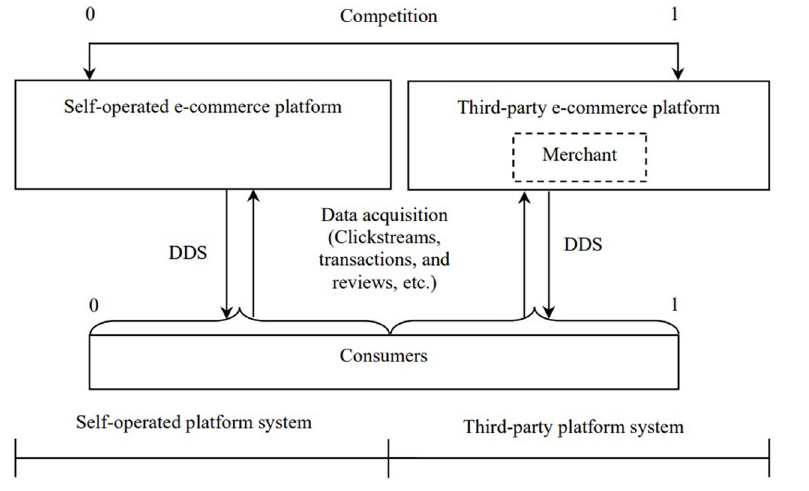
Fig 1. The framework for e-commerce platforms to implement DDS